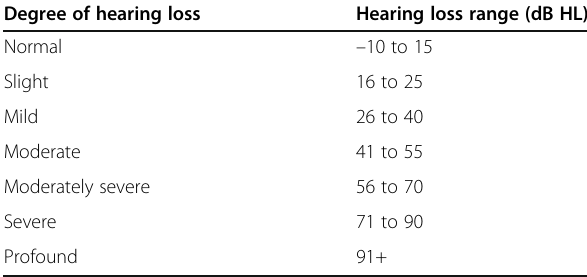
Table 1 Classification of degree of hearing